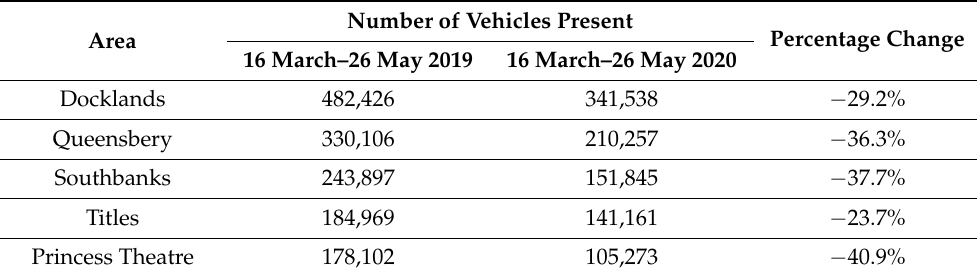
Table 3. Area level comparisons of parking volume in terms of number of vehicles present between